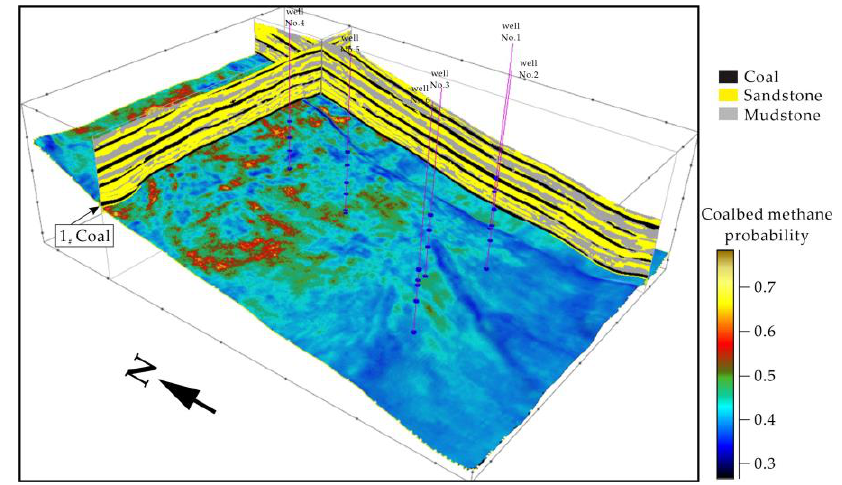
Figure 16. Plan of brittleness index of 1 # coal seam.